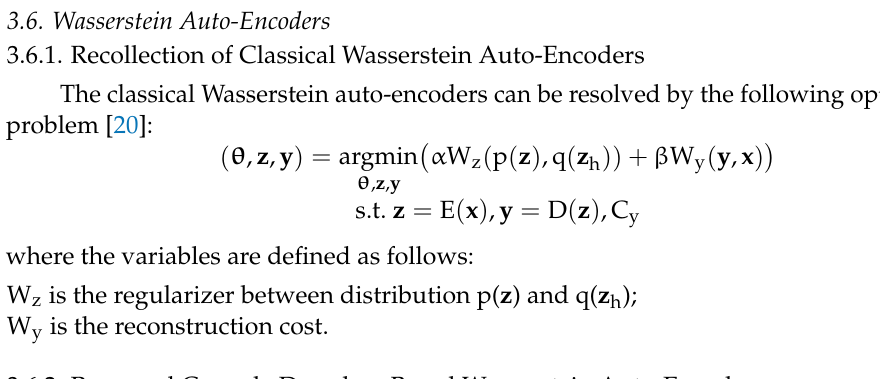
Figure 10. The architecture of cascade decoders-based variational auto-encoders.